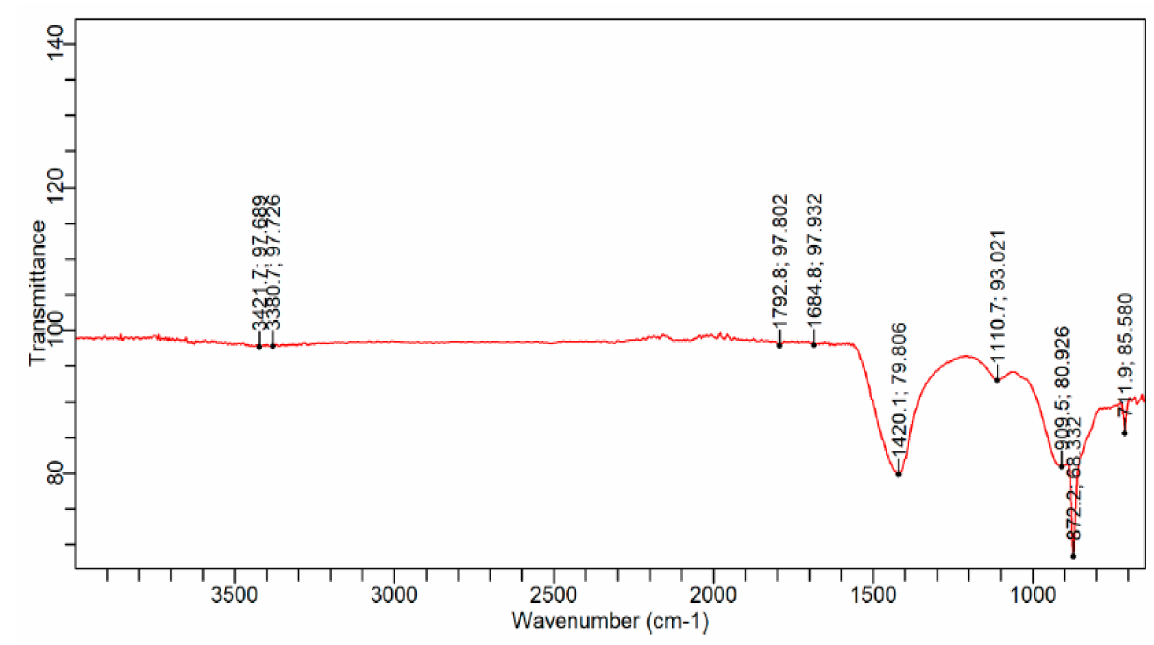
Figure 6. The FTIR/ATR spectra of CEM II.